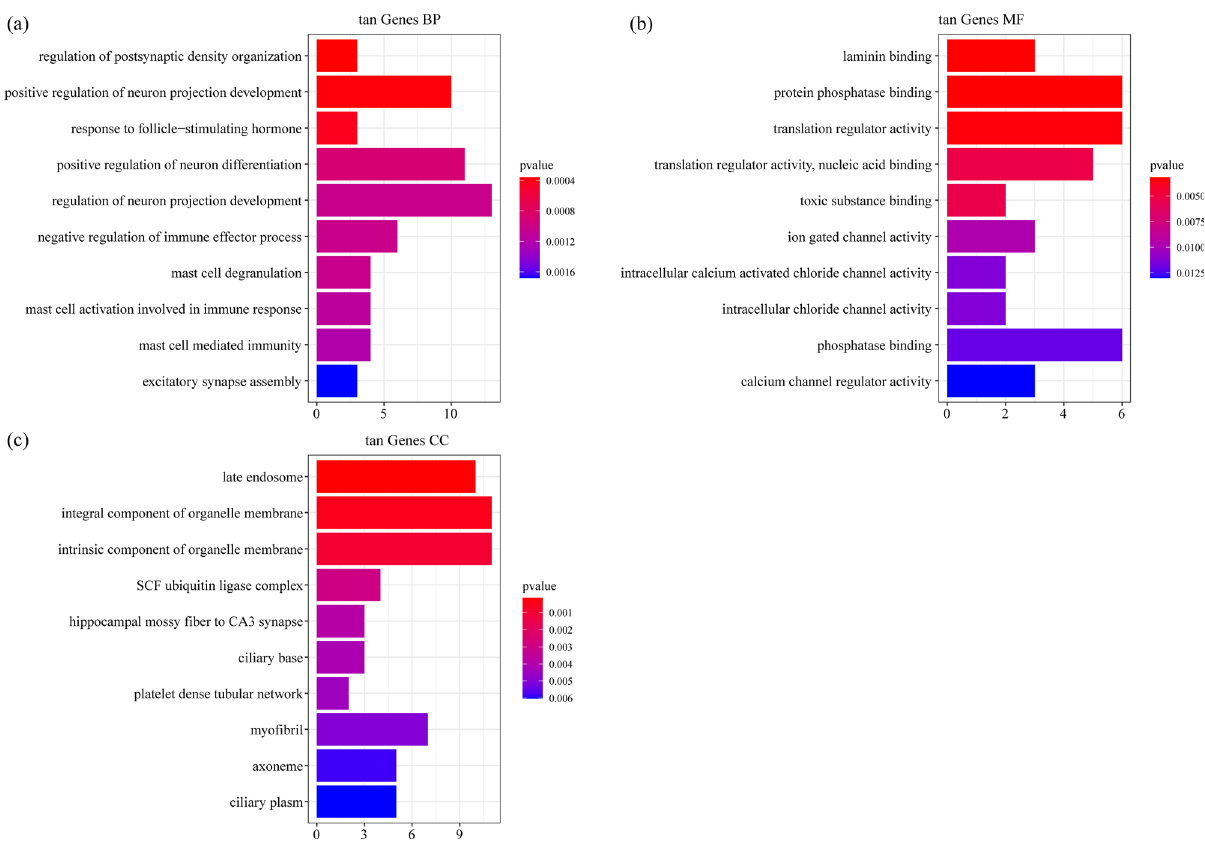
Figure 5: Functional enrichment analysis of DEGs in tan model: ( a ) the BP annotation map of DEGs in tan model, ( b ) the CC annotation map of DEGs in tan model, and ( c ) the MF annotation map of DEGs in tan model.